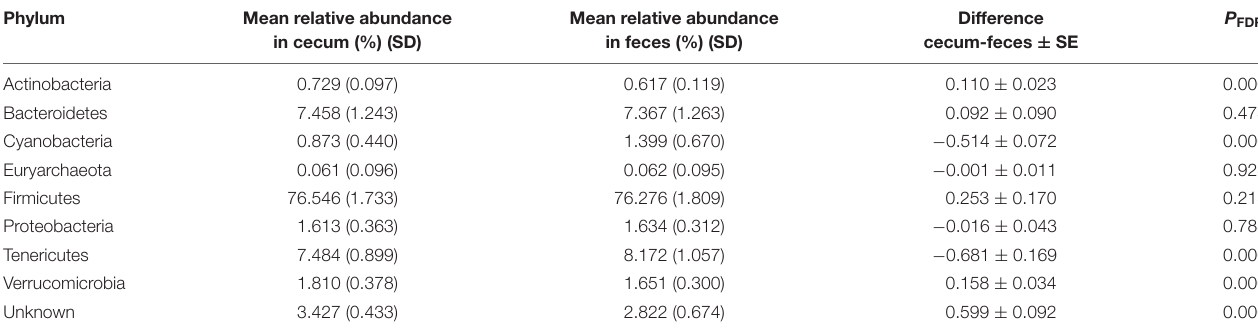
TABLE 4 | Microbial composition at phylum level in cecum and feces. Phylum